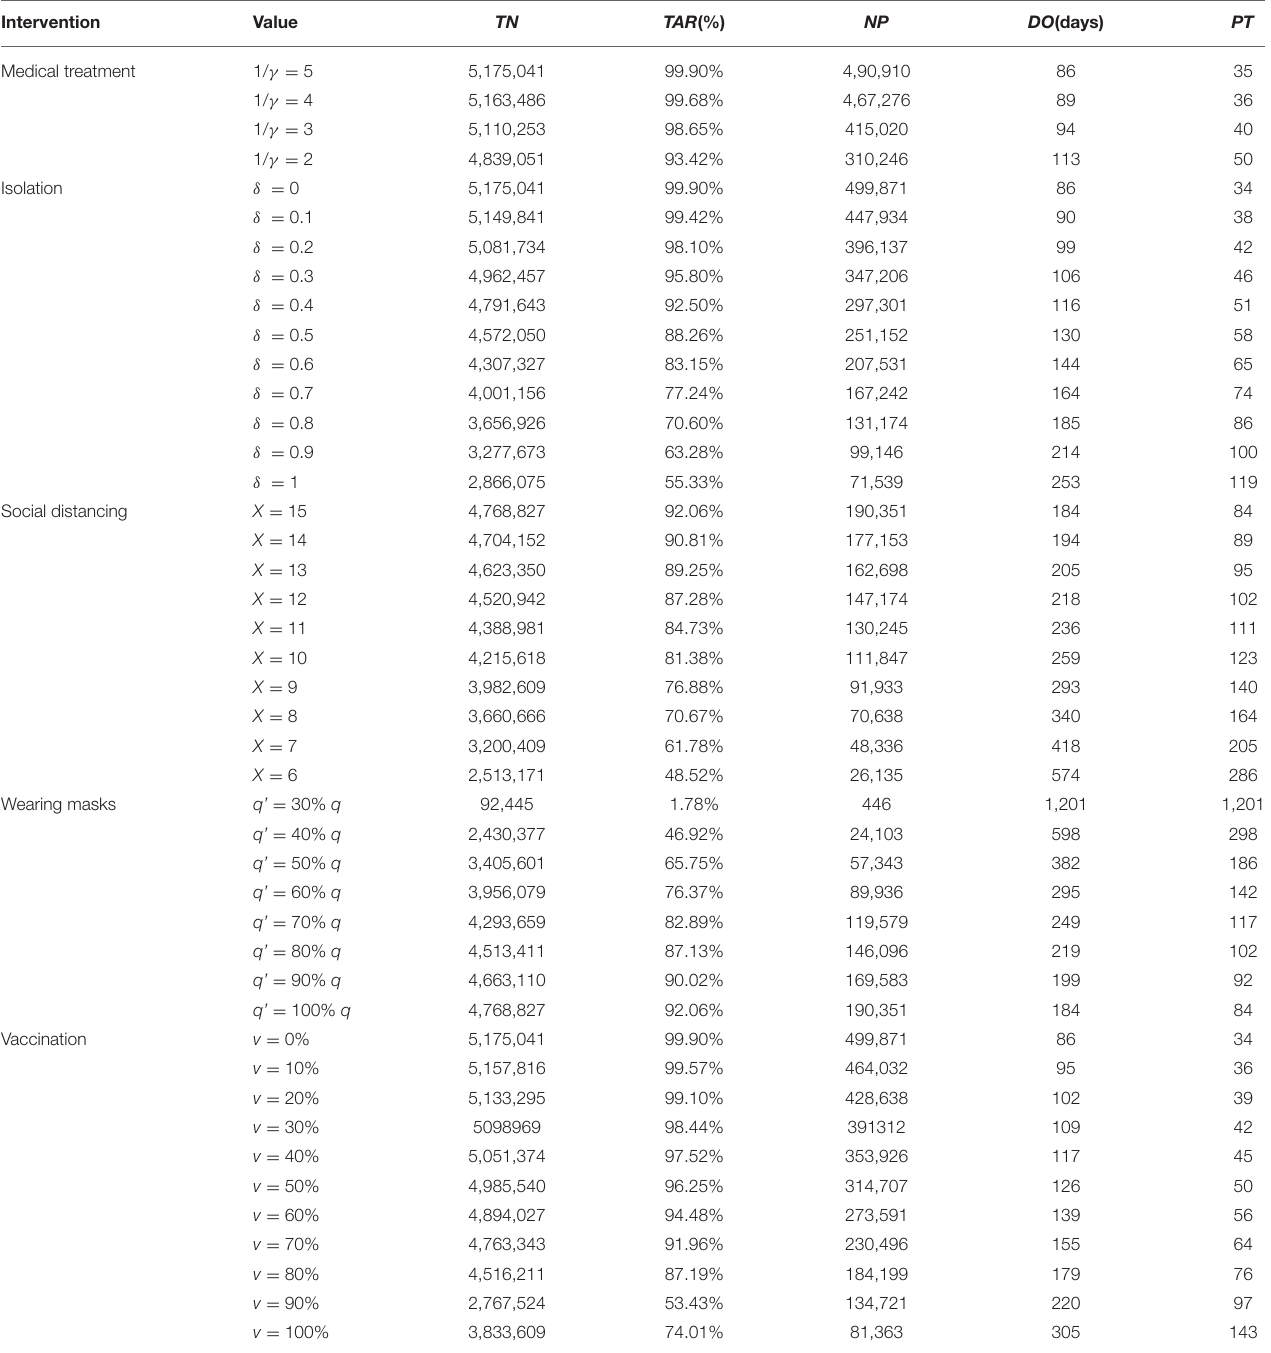
TABLE 4 | Single intervention effect